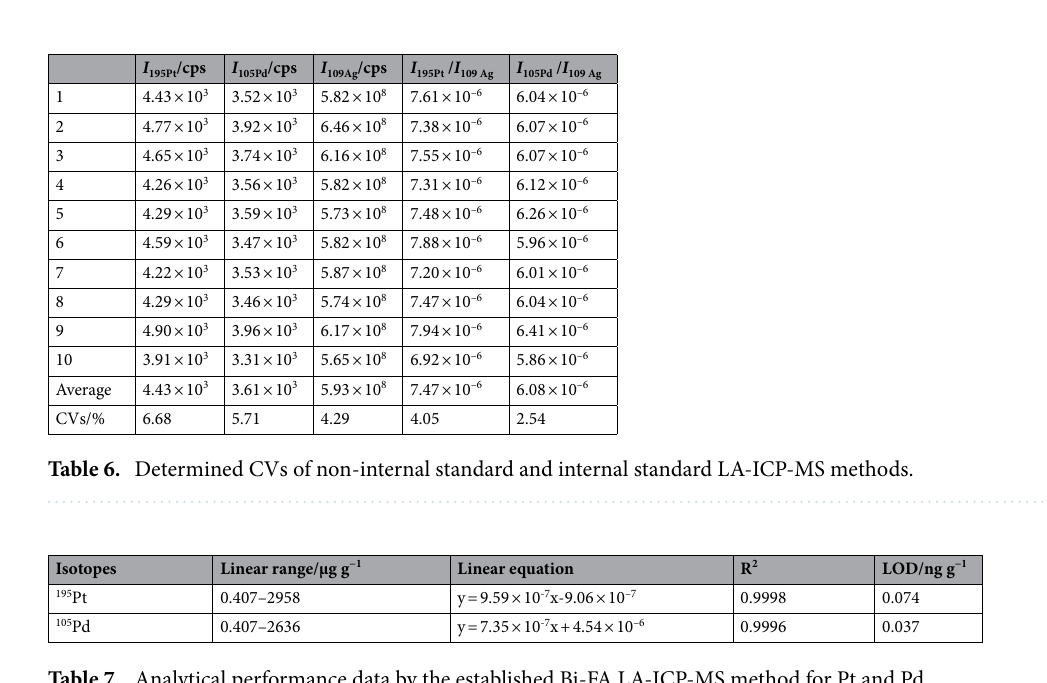
Table 7. Analytical performance data by the established Bi-FA LA-ICP-MS method for Pt and